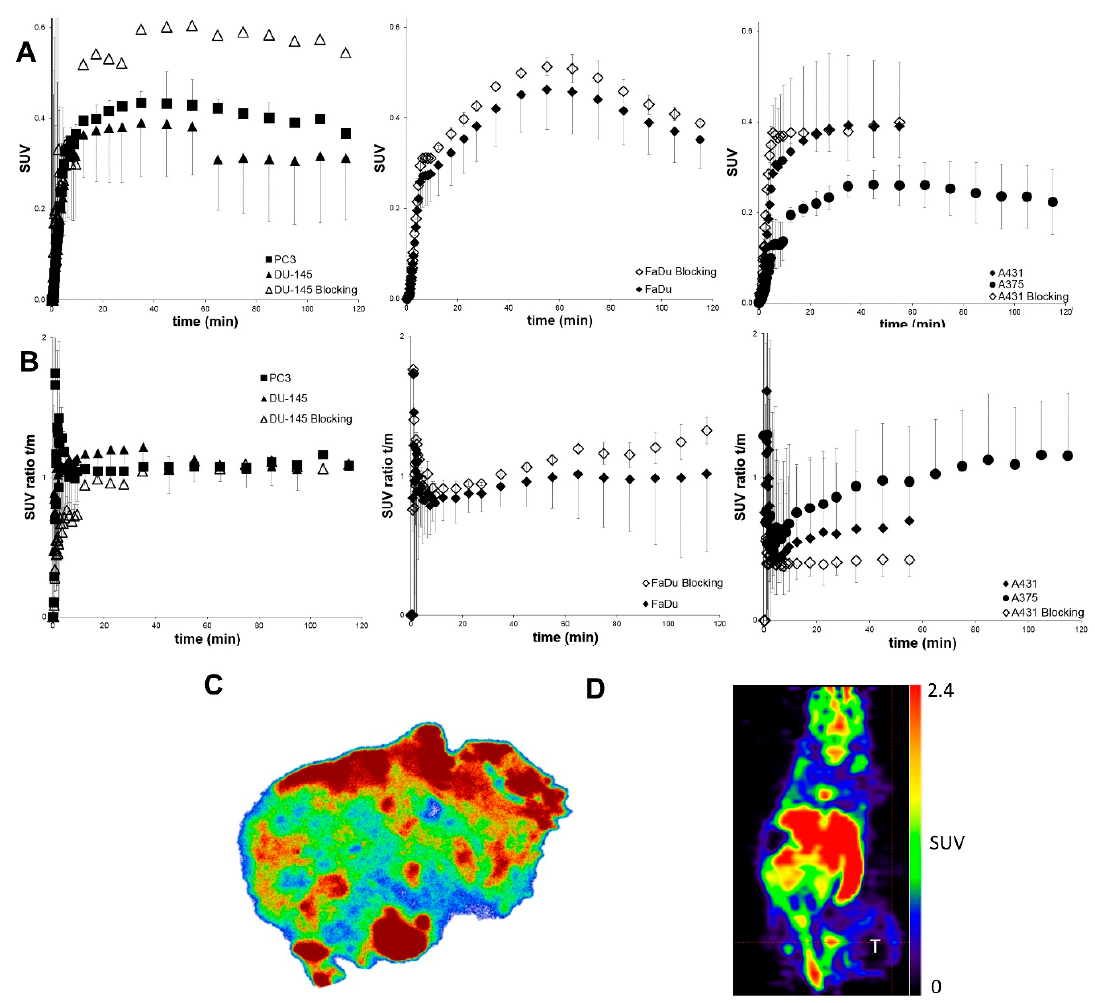
Figure 3. Small animal PET imaging in mice bearing different heterotopic tumors ( n = 2/tumor model; n = 1 for DU145 blocking) after i.v. injection of ( S )-( − )-[ 18 F]fluspidine. ( A ) The maximal tumor uptake corresponds to standardized uptake values (SUV) of 0.25 and 0.6 while a blocking effect is not visible (mean SUV ± SD). ( B ) Tumor-to-muscle SUV ratios of the respective animals (mean SUV ratio ± SD). ( C ) In vitro Sig1R autoradiography with ( S )-( − )-[ 18 F]fluspidine of an explanted U87-MG tumor, grown heterotopically in a mouse, with heterogeneous activity distribution. ( D ) Representative coronal PET image of a FaDu tumor bearing mouse at 50–60 min p.i. (tumor highlighted, T).